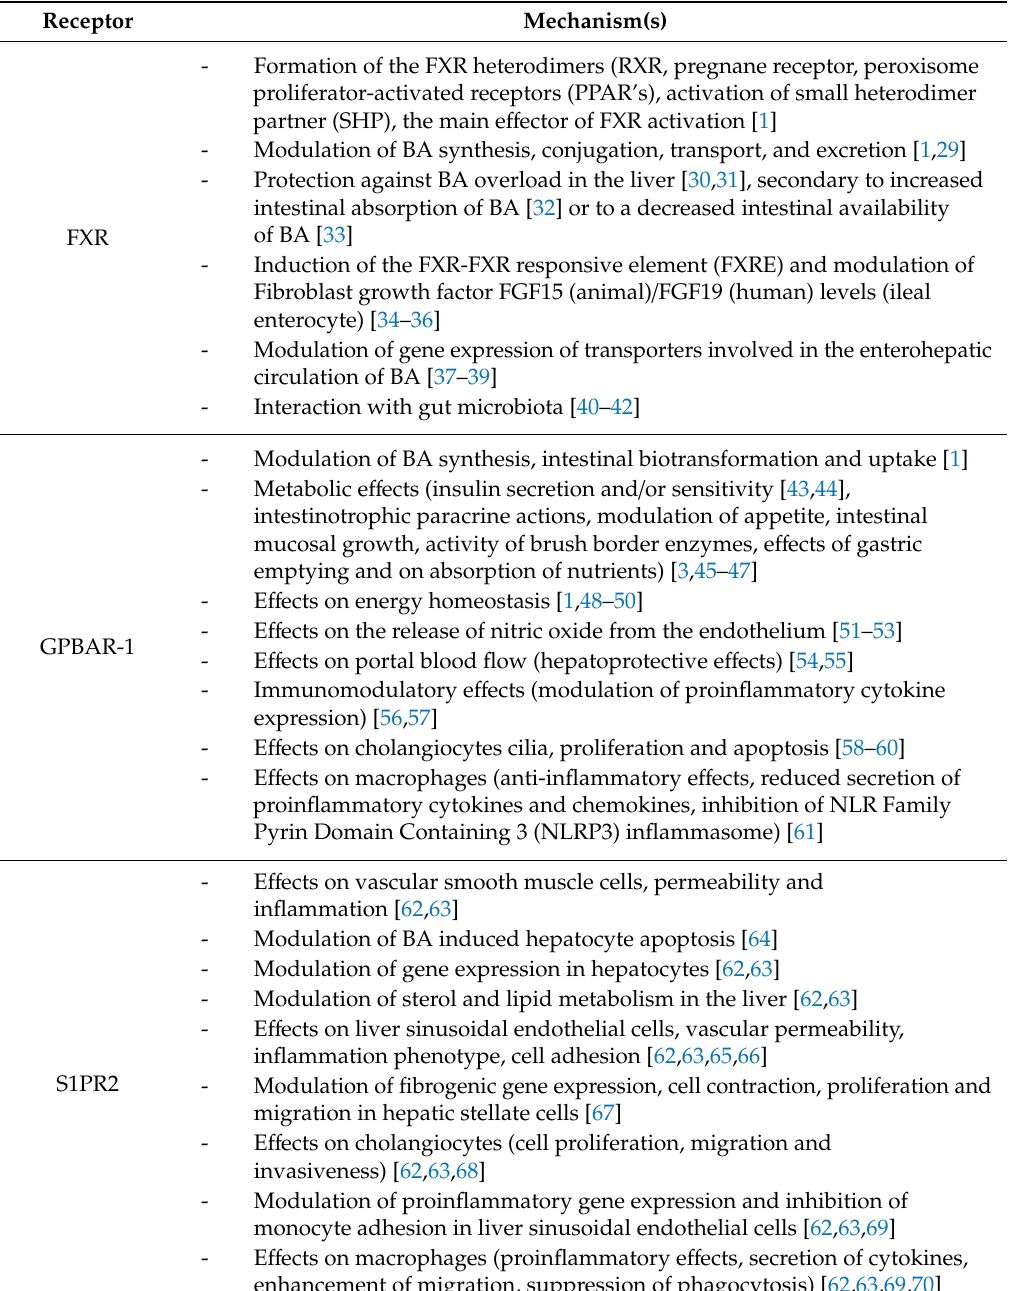
Table 1. E ff ects of bile acid (BA) interactions with the Farnesoid X receptor (FXR), G